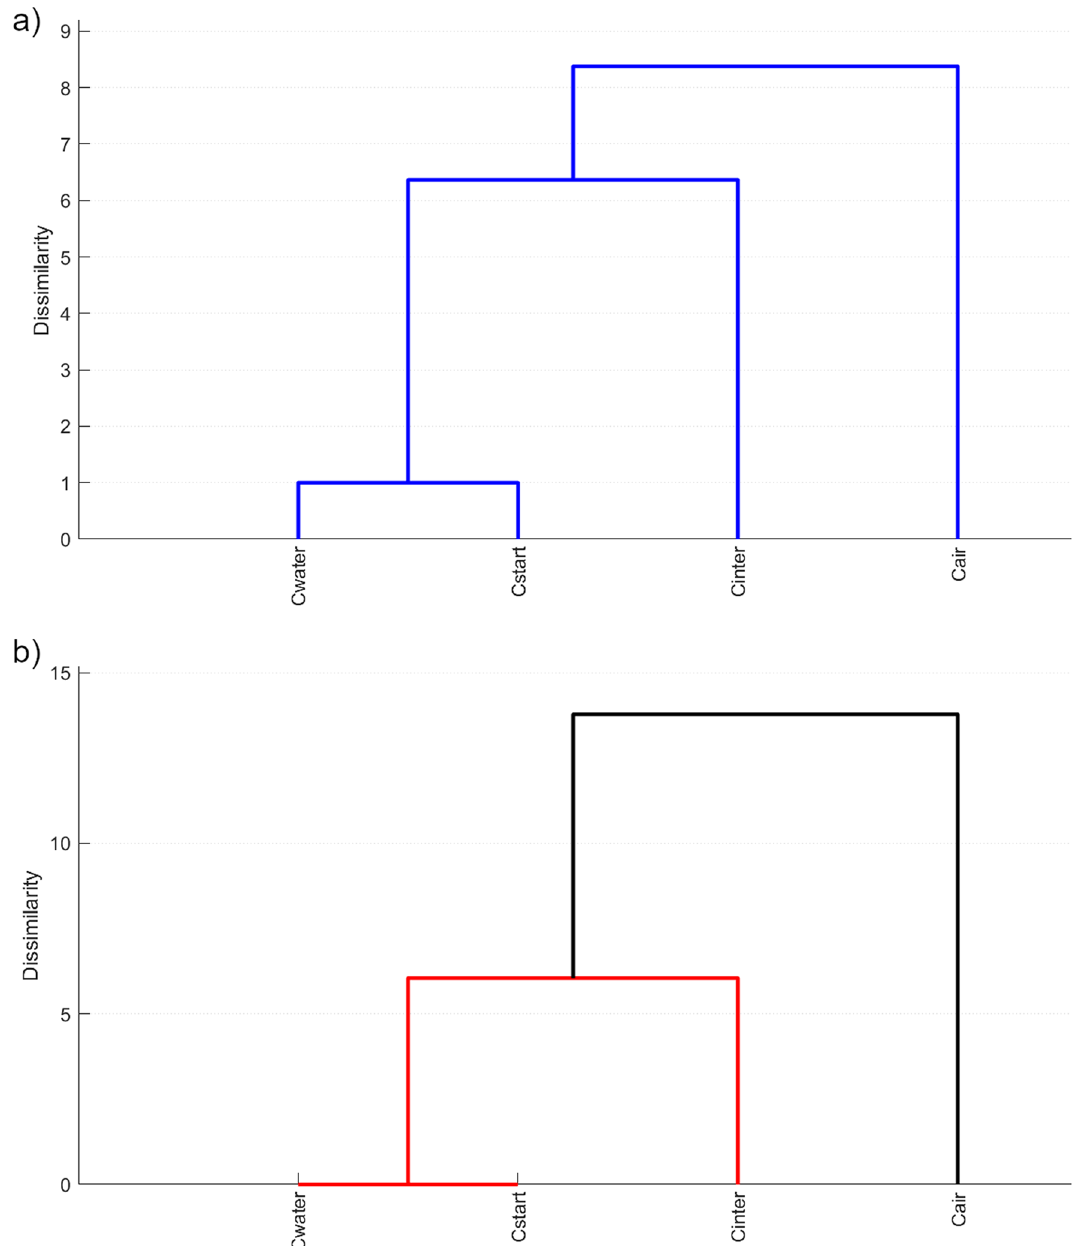
Figure 6. Results of DAPM with shape parameter subsets. ( a ) Dendrogram resulting from using AR_LI, Con_LI and Sol_LI. ( b ) Dendrogram produced by DAPM using Con_LI, Circ_SC, Rec_SC, FF_1 and AR_F (for notation see Table 1). Using DAPM with a limited number of shape parameters with low redundancy is recommended if the aim is to explore relative